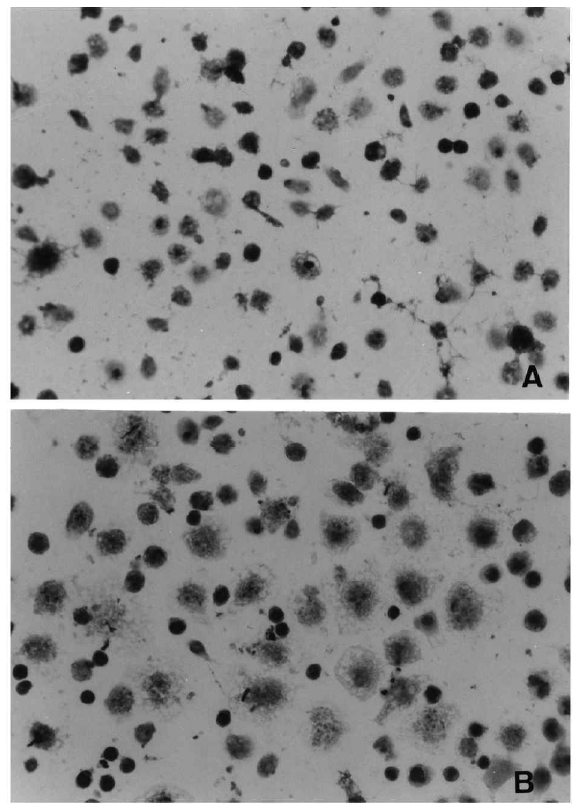
FIG. 6. Photomicrography of cells obtained from the peri- toneal cavity of animals injected with Cg 4h before and immunostained for the calcium-binding protein MRP-14 (A). In B, cells obtained from the peritoneal exudate induced by Cg injection in an animal previously depleted of neutrophils. The expression of MRP-14 is more intense in this prepara- tion. Optic microscopy ( ´